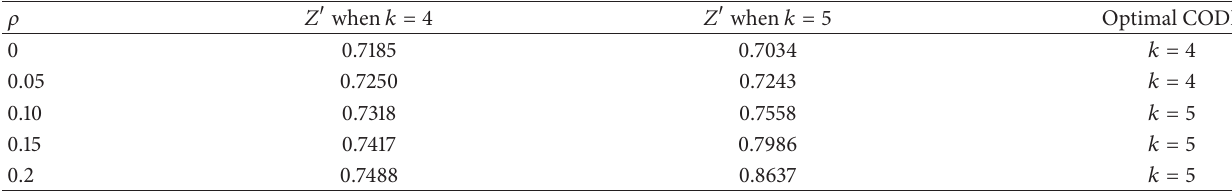
Table 7: Results of 𝑍 󸀠 varied with 𝜌 .